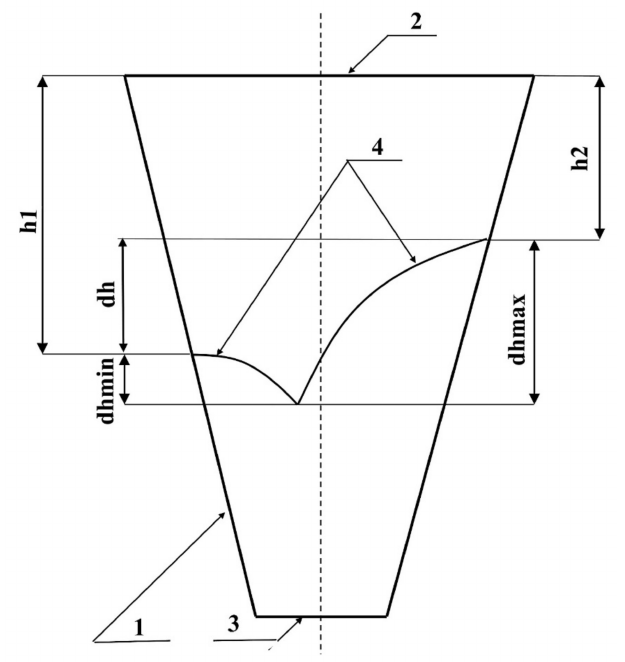
Figure 7. Parameters recorded in the process of grain flowing downwards in the unloading hopper: ( 1 ) Experimental model; ( 2 ) Upper edge; ( 3 ) Outlet hole; ( 4 ) Upper border of grain layer flowing downwards.